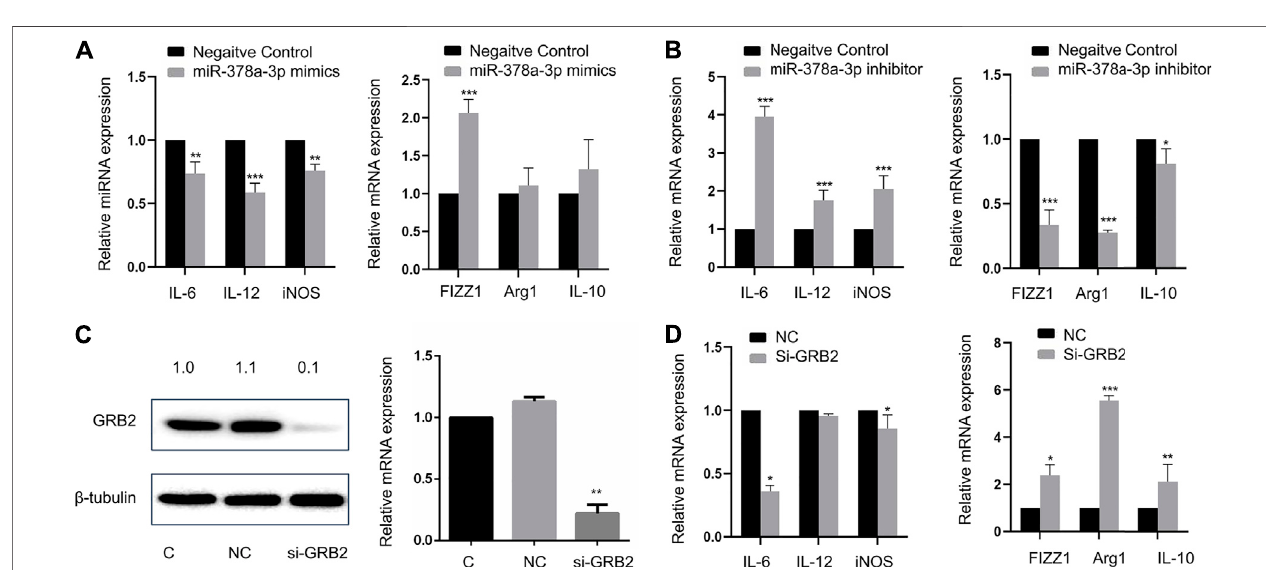
FIGURE 6 | (A) MiR-378a-3p contributes to alveolar macrophage polarization by targeting GRB2 Expression of IL-6, IL-12, iNOS, FIZZ1, Arg1, and IL-10 in MH-S cellstreatedwith100 pmolmiR-378a-3p mimics ornegative controlfor48 hvaluatedbyRT-qPCR (B) .ExpressionofIL-6,IL-12,iNOS, FIZZ1,Arg1, andIL-10inMH-S cellstreatedwith100 pmolmiR-378a-3p inhibitorornegativecontrolfor48 hevaluatedbyRT-qPCR (C) .GRB2mRNAandproteininMH-Scellstreatedwith100 pmol si-GRB2 for 48 h measured by RT-qPCR and Western Blot (D) . Expression of IL-6, IL-12, iNOS, FIZZ1, Arg1, and IL-10 in MH-S cells treated with 100 pmol si- GRB2 for 48 h evaluated by RT-qPCR. (* p < 0.05, ** p < 0.01, *** p < 0.001 vs.